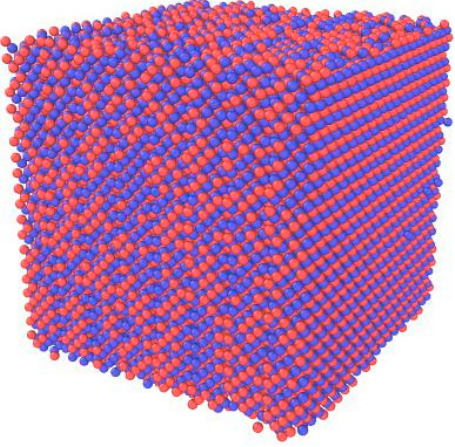
Figure 1. The Ti-Al alloy system.